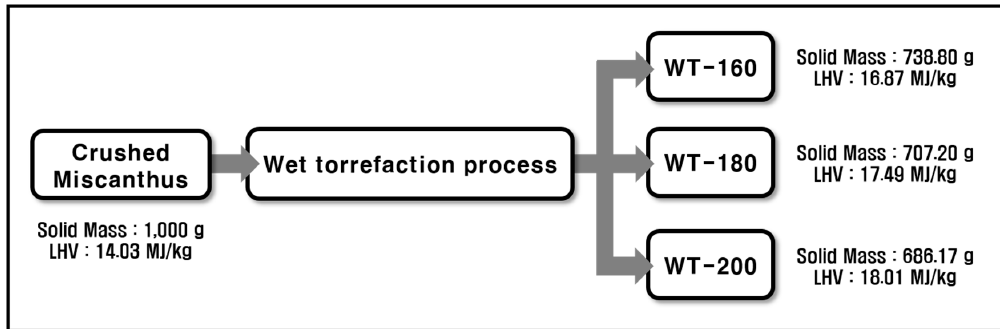
Figure 2. Flow chart and mass balance of the wet torrefaction process.